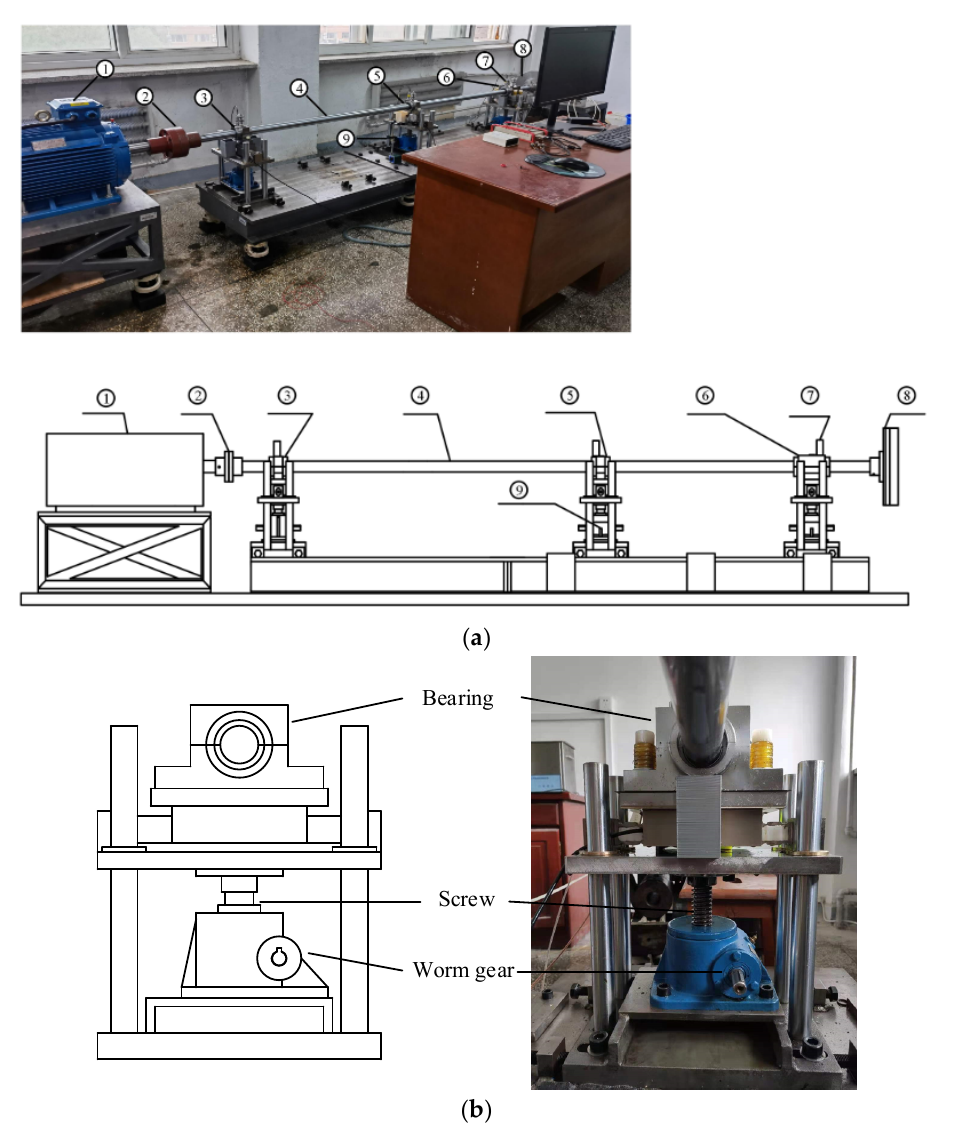
Figure 1. The ship propulsion shafting test bench. ( a ) Test bench: 1 Driving motor; 2 Coupling; 3 Intermediate bearing; 4 Transmission shafting; 5 Front stern bearing; 6 Aft stern bearing; 7 Acceleration sensor; 8 Counterweight plate; 9 worm gear screw lifter; ( b ) Worm gear screw lifter.